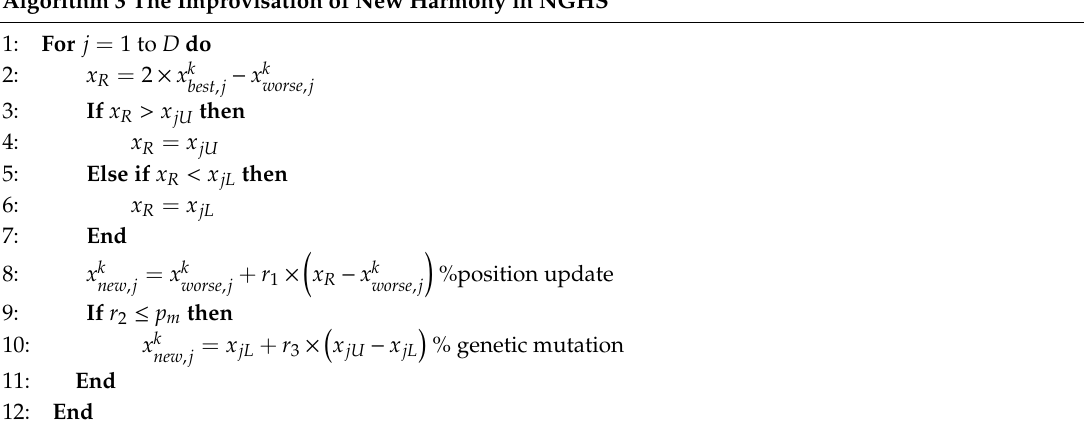
Algorithm 3 The Improvisation of New Harmony in